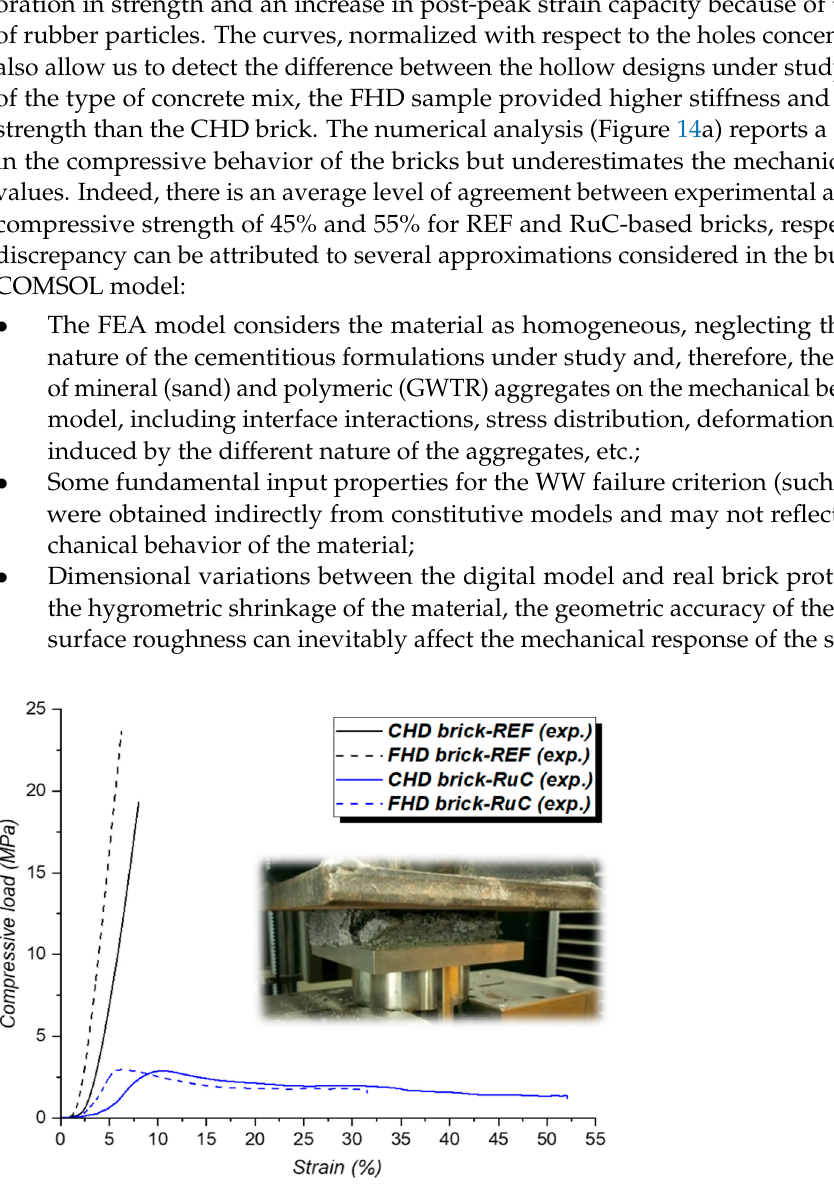
Figure 16. Experimental load–strain curves.